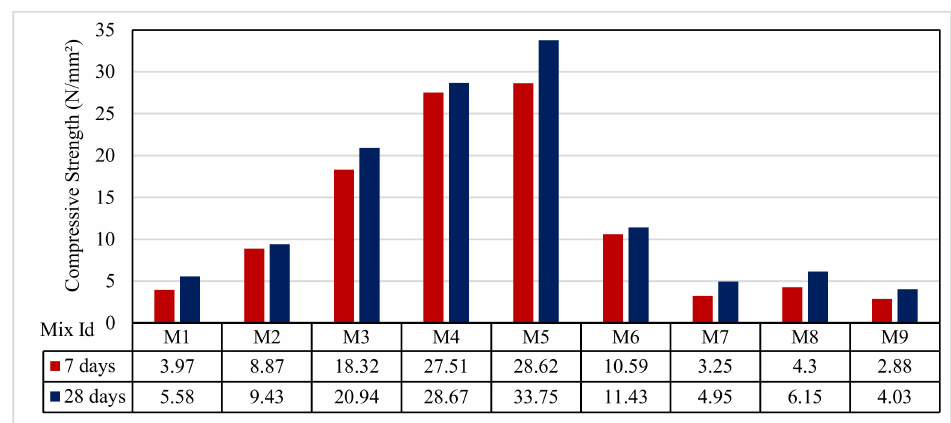
Figure 8. The compressive strength test